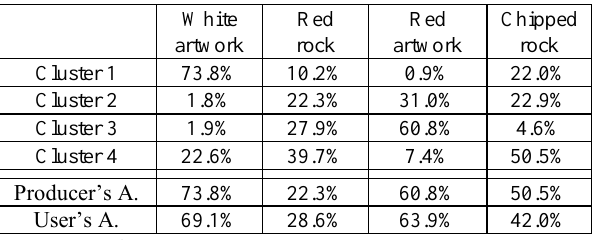
Table 4: Confusion matrix test 3.